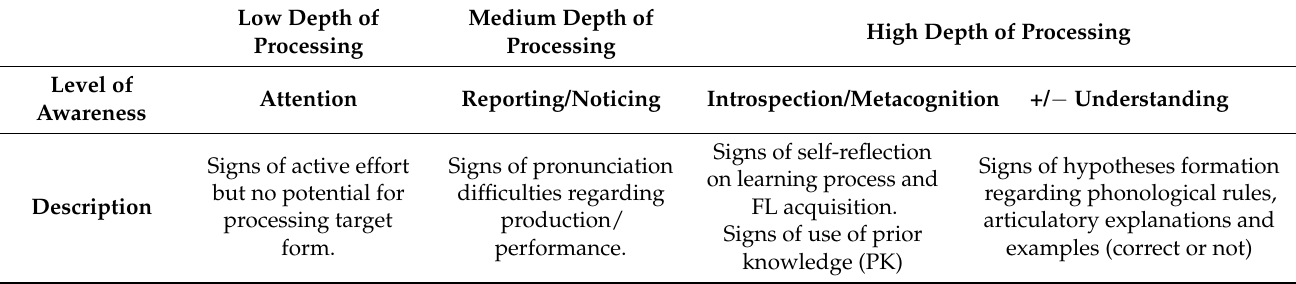
Table 1. Operationalization of Depth of Processing: Pronunciation/Phonological items (adapted from Wrembel (2013, 2015), and Leow